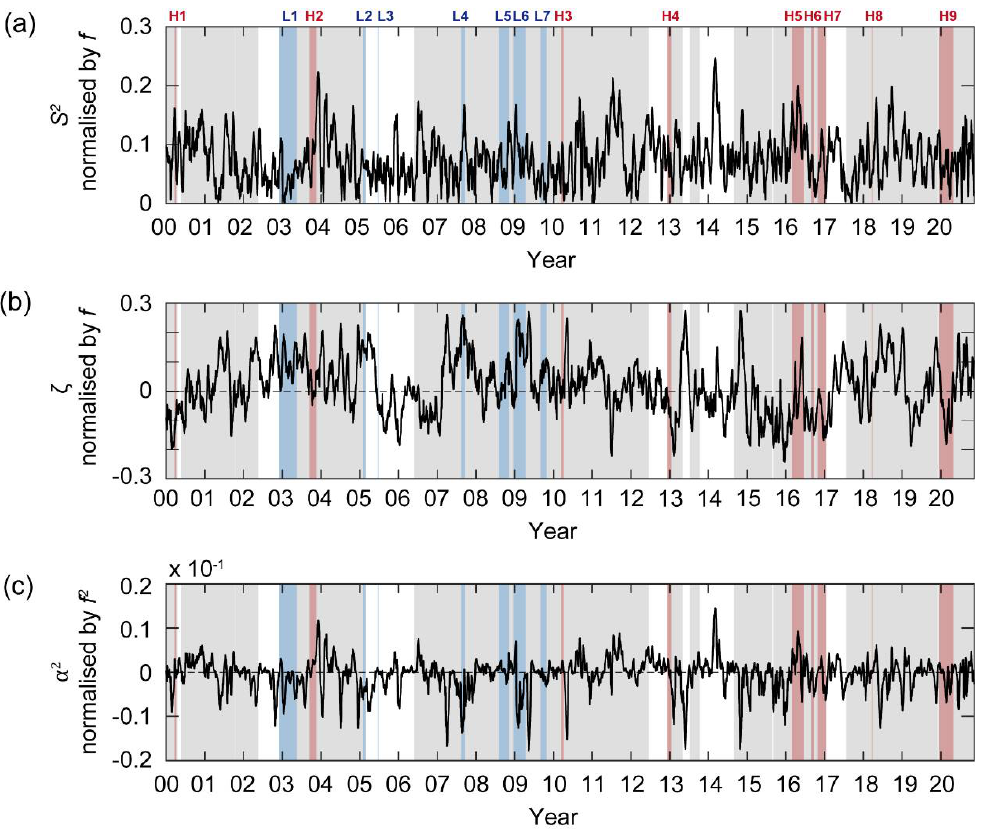
Figure 9. Time series of ( a ) S 2 normalised by f , ( b ) ζ normalised by f , and ( c ) α 2 normalised by f 2 . Red (blue) shaded boxes indicate period high (period low). Grey shaded area indicates period